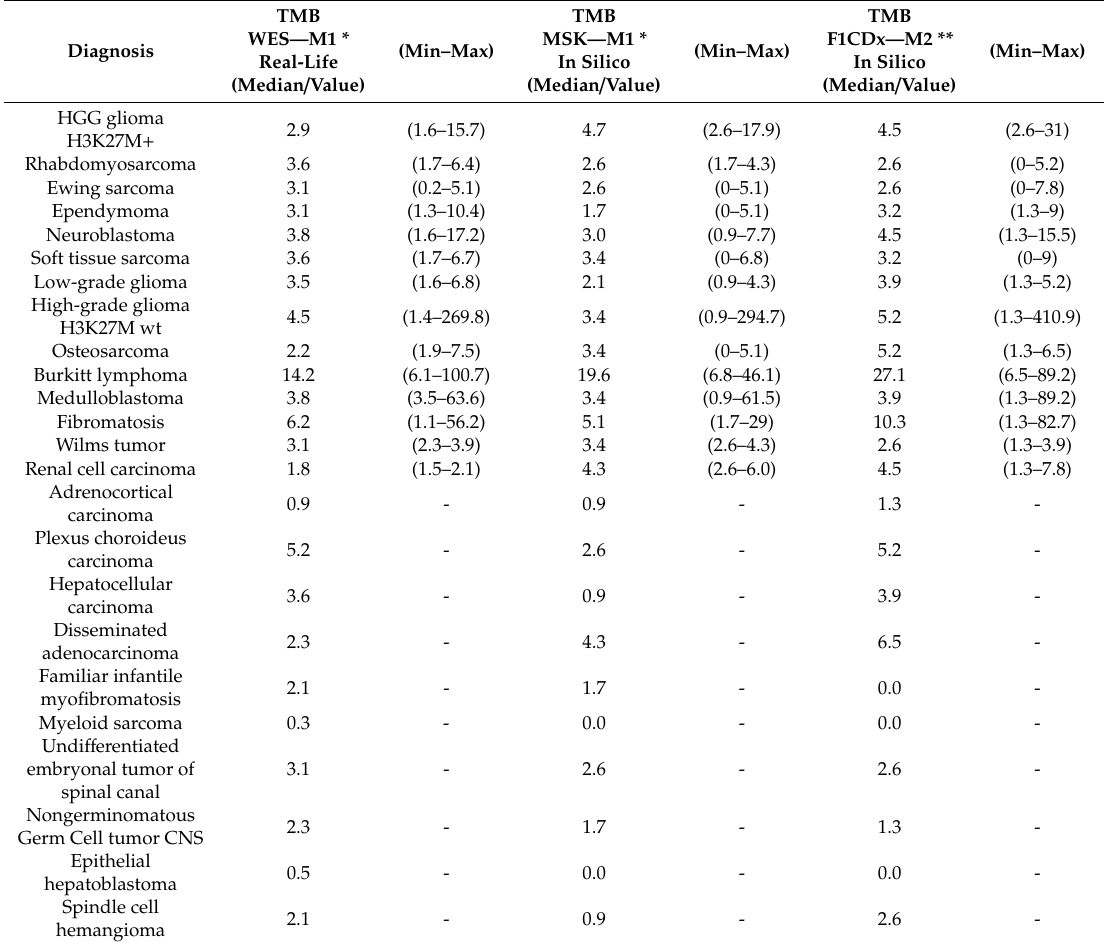
Table 1. Comparison of TMB determined by real-life WES and in silico targeted gene